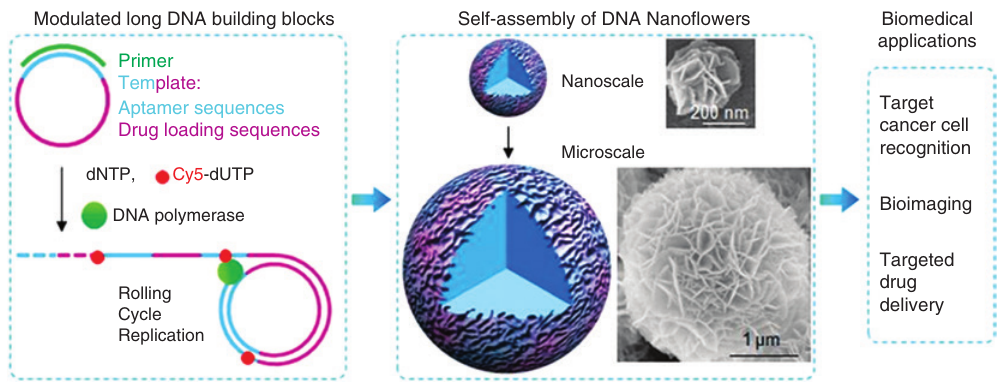
Figure 6: Schematic illustration of noncanonical self-assembly of multifunctional DNA NFs. Reprinted with permission of Ref. [75]. © Copy- right 2013 American Chemical